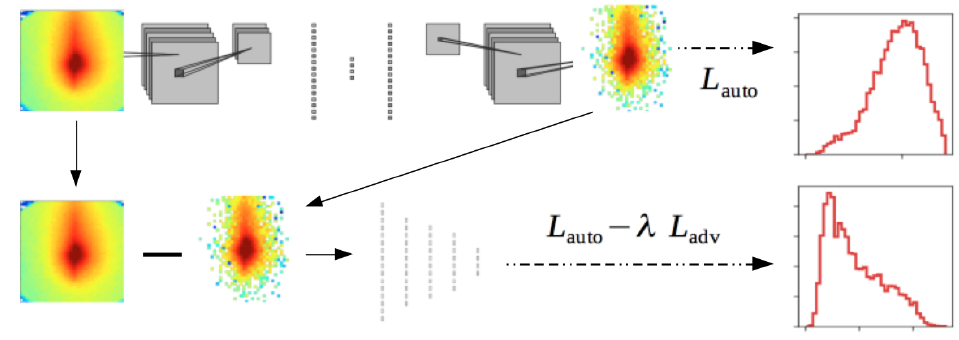
Figure 11: Illustration of our network